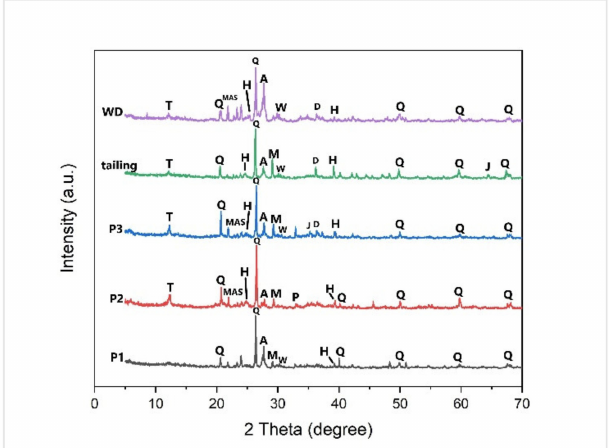
Figure 2. Raw Fe-rich mine waste X-ray diffractograms patterns of Caption should be: waste dump (WD), tailing, pond 1 (P1), pond 2 (P2), and pond 3 (P3). Labelled alphabet represents the minerals found in the waste: quartz (Q), anorthite (A), wollastonite (W), diopside (D), titanium silicon (T), magnetite (M), perovskite (P), magnesium aluminium silicate (MAS), johannsenite (J) and hematite